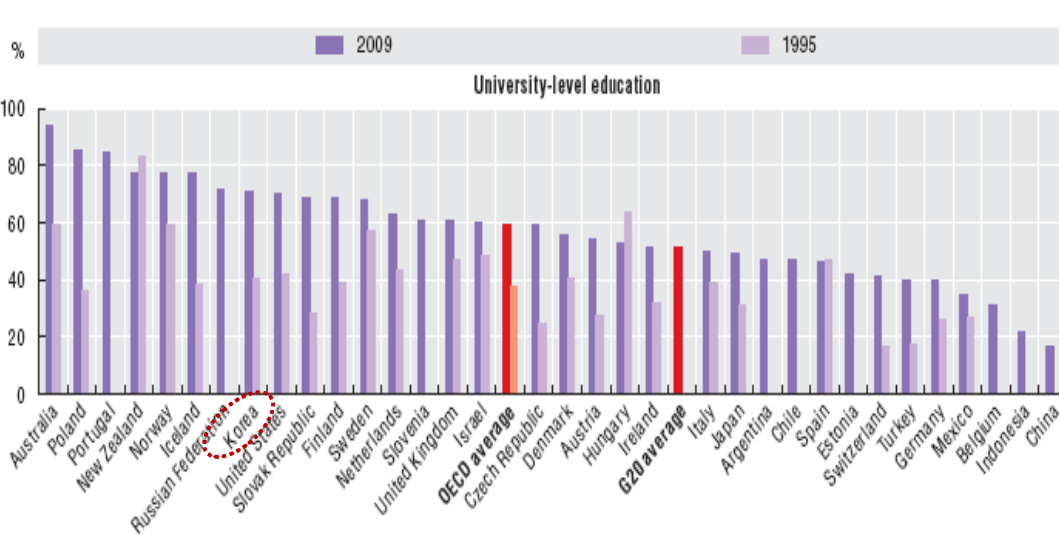
Figure 1. University-level education of OECD member nations (OECD, 2011, p.